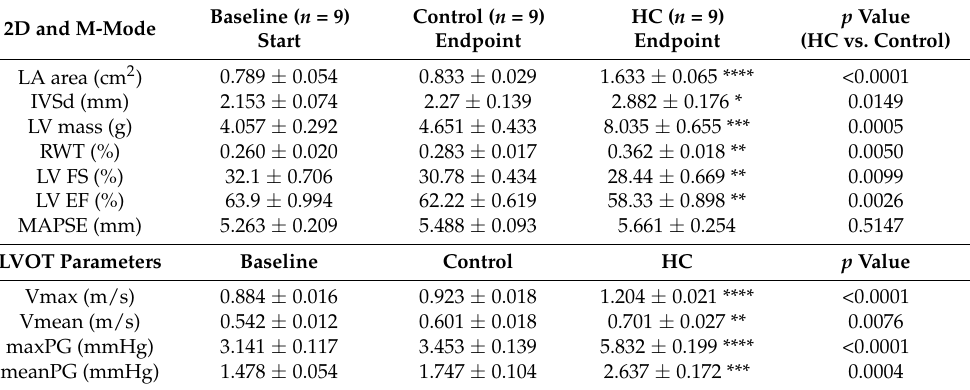
Table 2. Echocardiographic (Doppler, TVI, and speckle tracking) parameters of rabbits at the endpoint of the study. Significant differences were found in E/A and E/e’ ratios, DecT, IVRT, Tei-index and GLS in HC animals compared to Controls. Asterisks denote the level of significance, compared to the Control (** p < 0.01; *** p < 0.001; **** p < 0.0001). MV: mitral valve; ms: milliseconds; E vel: peak velocity flow in early diastole A vel: peak velocity flow in atrial contraction (late diastole); E/A ratio: ratio of peak velocity flow in early diastole to peak velocity flow in atrial contraction; DecT: deceleration time of the E wave, Sept: septal; e’: peak velocity of early diastolic annular motion; a’: peak velocity